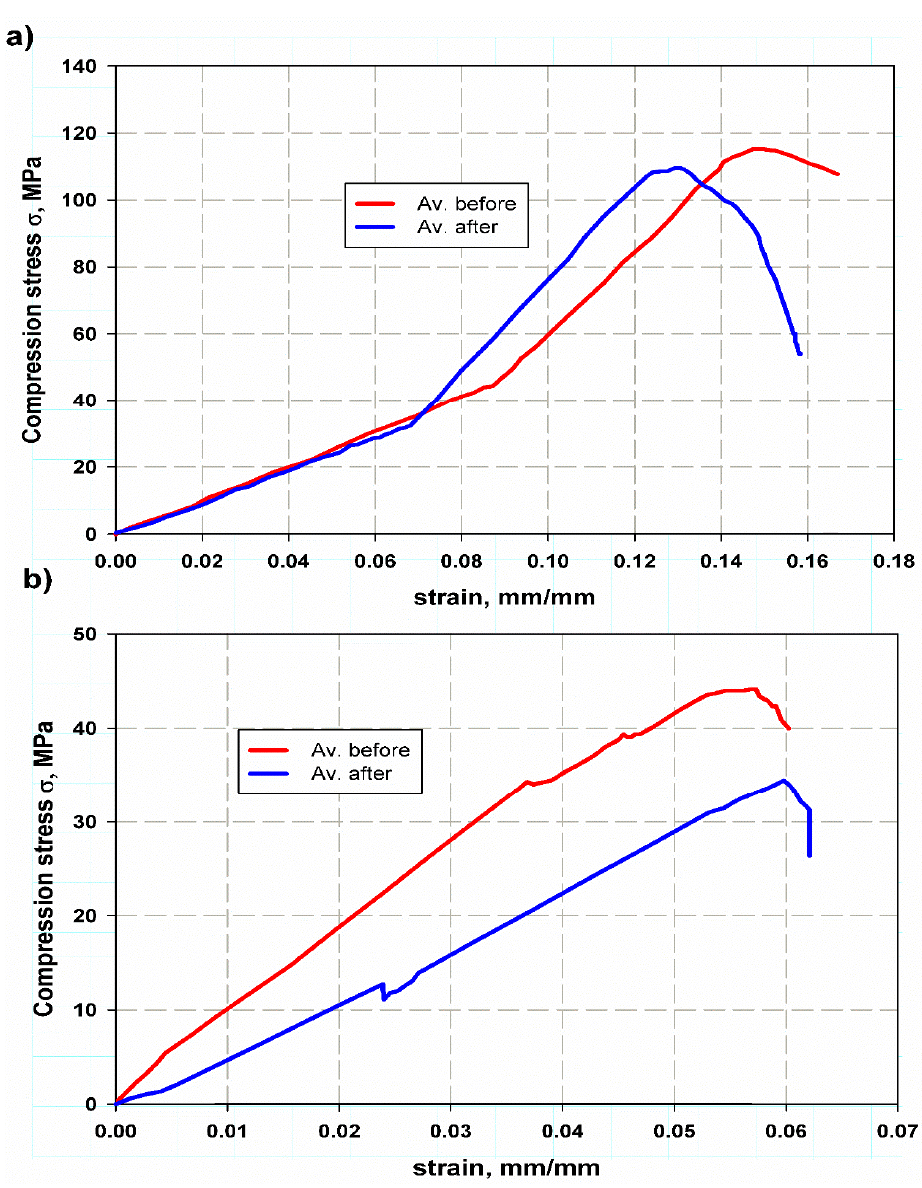
Figure 11. Composite pipe compressive behaviors; ( a ) transverse, ( b ) longitudinal.